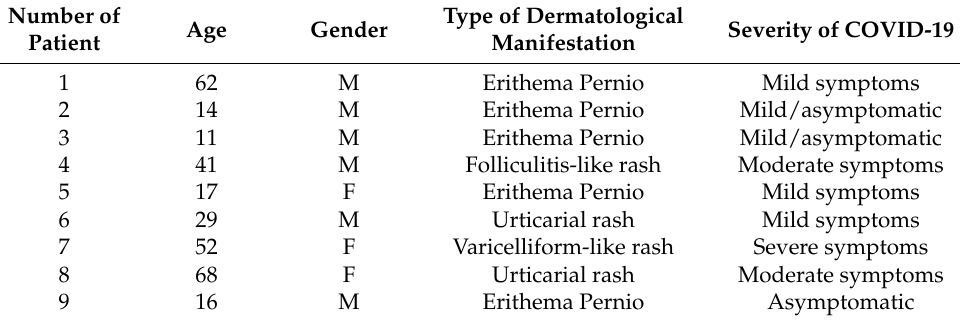
Table 1. Clinical characteristics of the patients enrolled in this